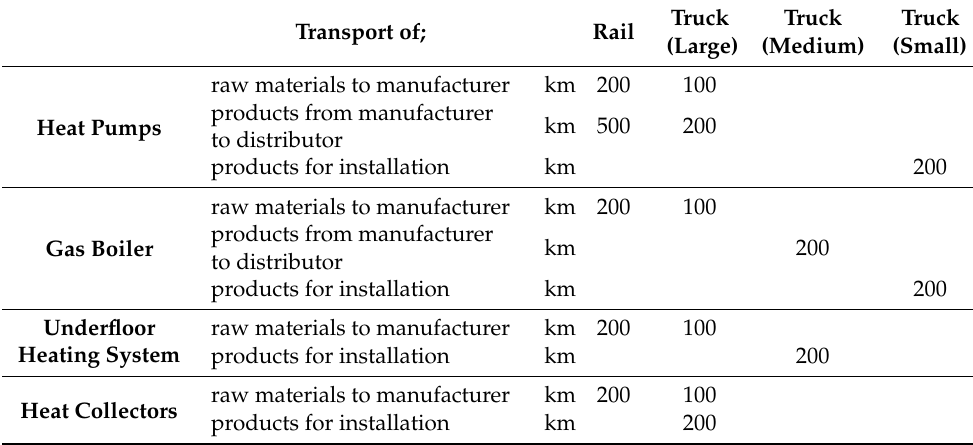
Table 3. Transport assumptions. Data source: [36].